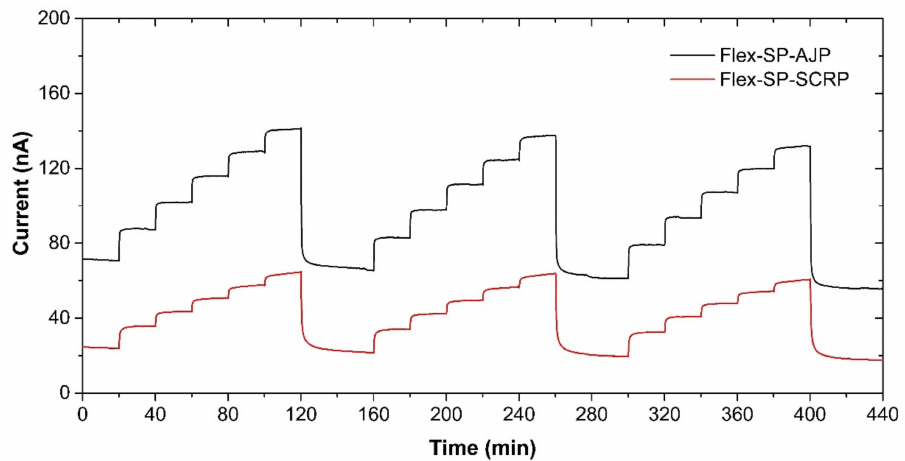
Figure 9. Sensor response of the semi-planar topology on the flexible Kapton substrate to the stepwise increase in ethylene concentration within the range 0–500 ppm in steps of 100 ppm. Conditions: 22 ◦ C, 40%RH, 101.325 kPa, 1